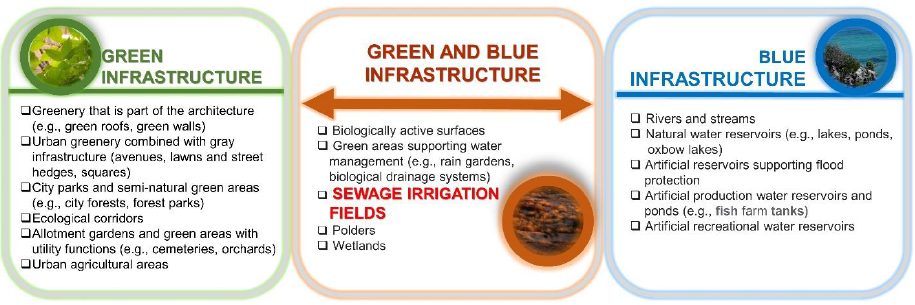
Figure 2. The place of sewage irrigation fields in blue-green infrastructure in the urban fabric (own elaboration).